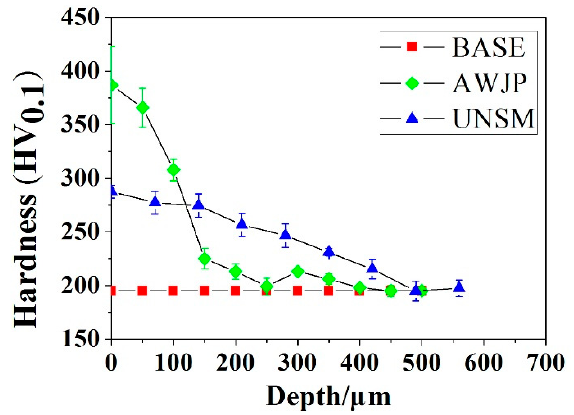
Figure 8. Hardness-depth profile of the 304 stainless-steel BASE, AWJP, and UNSM specimens .